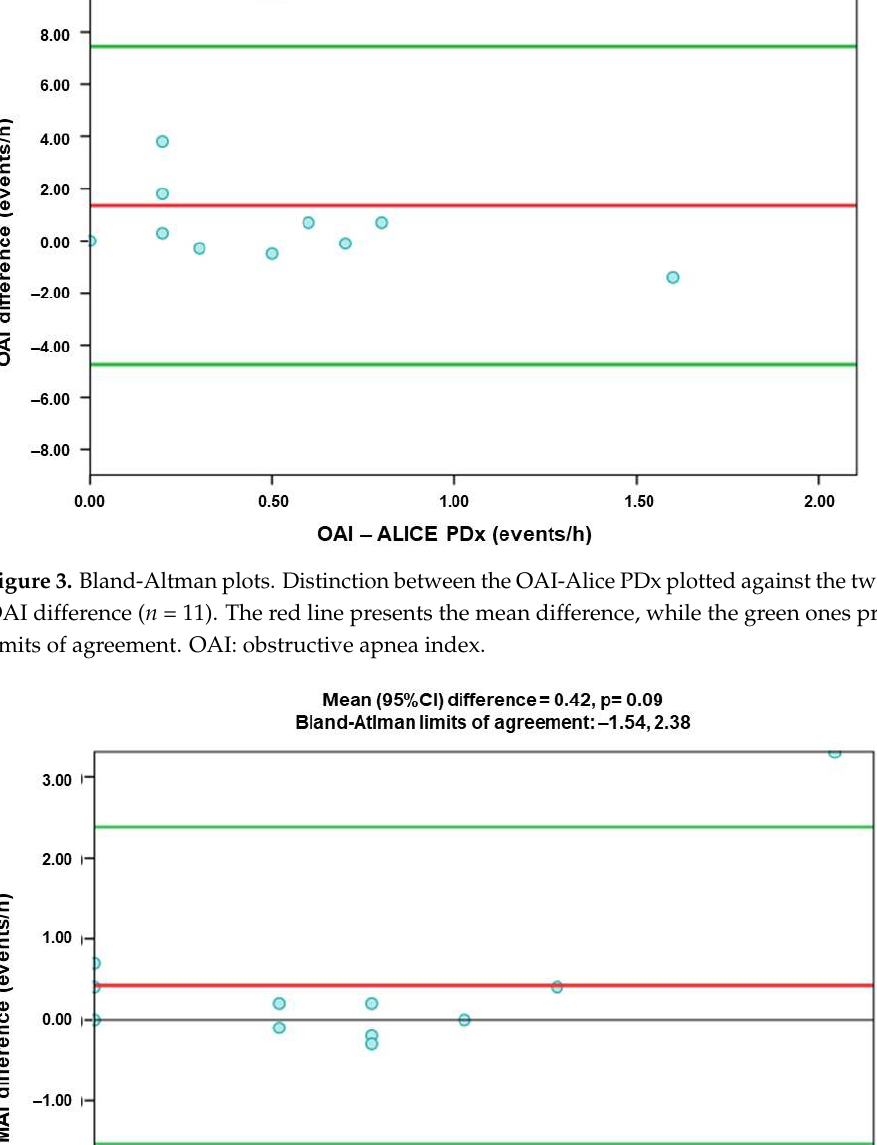
Figure 4. Bland-Altman plots. Distinction between the MAI-Alice PDx plotted against the two devices’ MAI difference ( n = 11). The red line presents the mean difference, while the green ones reveal the limits of agreement. MAI: mixed apnea